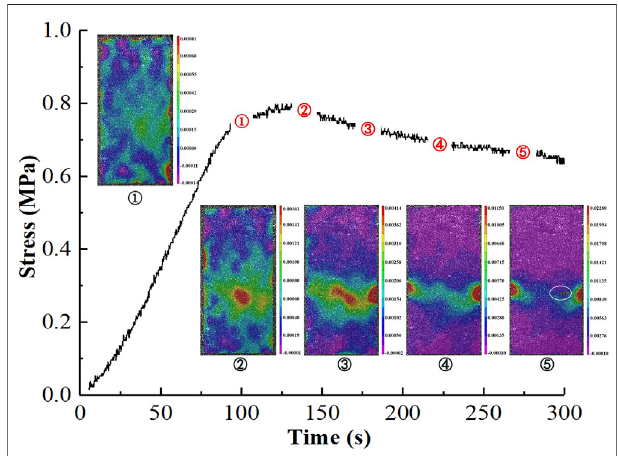
FIGURE 12 | The apparent strain fi eld of T-0.4.